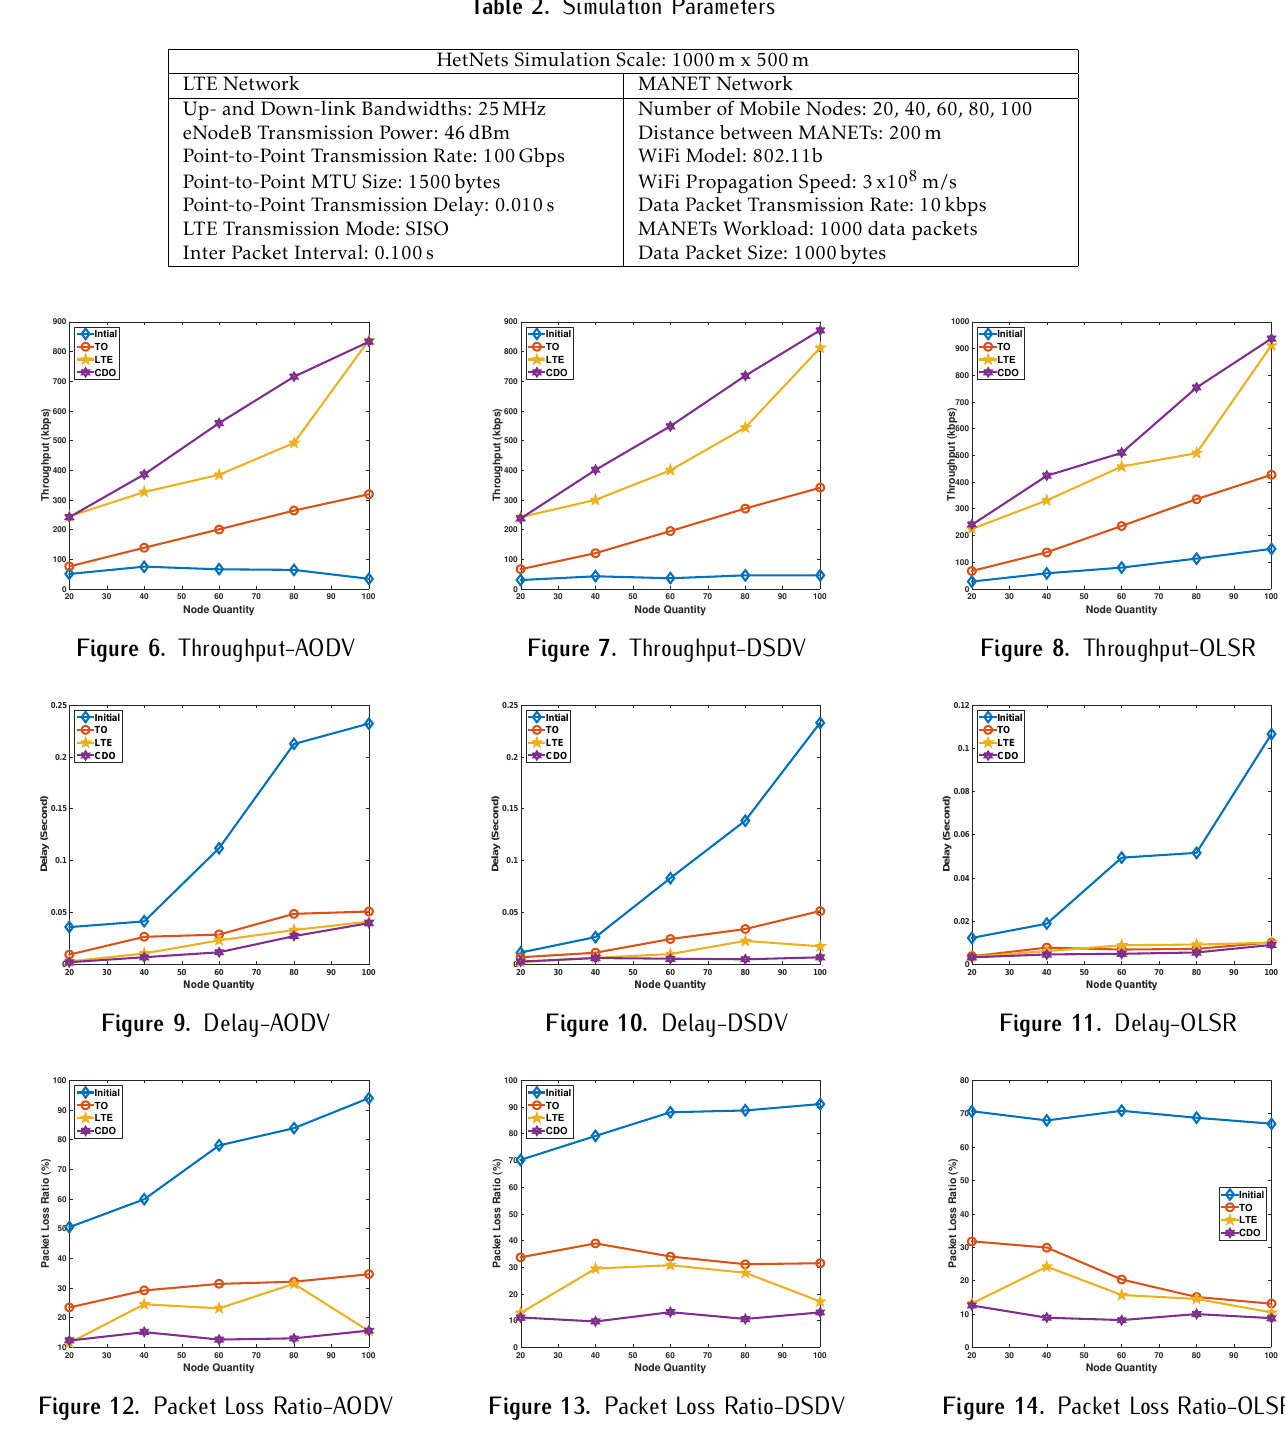
Figure 12. Packet Loss Ratio-AODV Figure 13. Packet Loss Ratio-DSDV Figure 14. Packet Loss